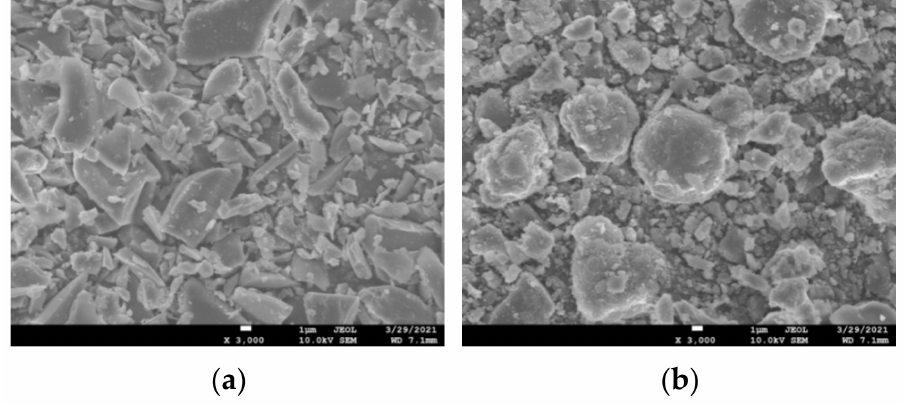
Figure 4. SEM images of ( a ) slag × 3000 and ( b ) RCP ×